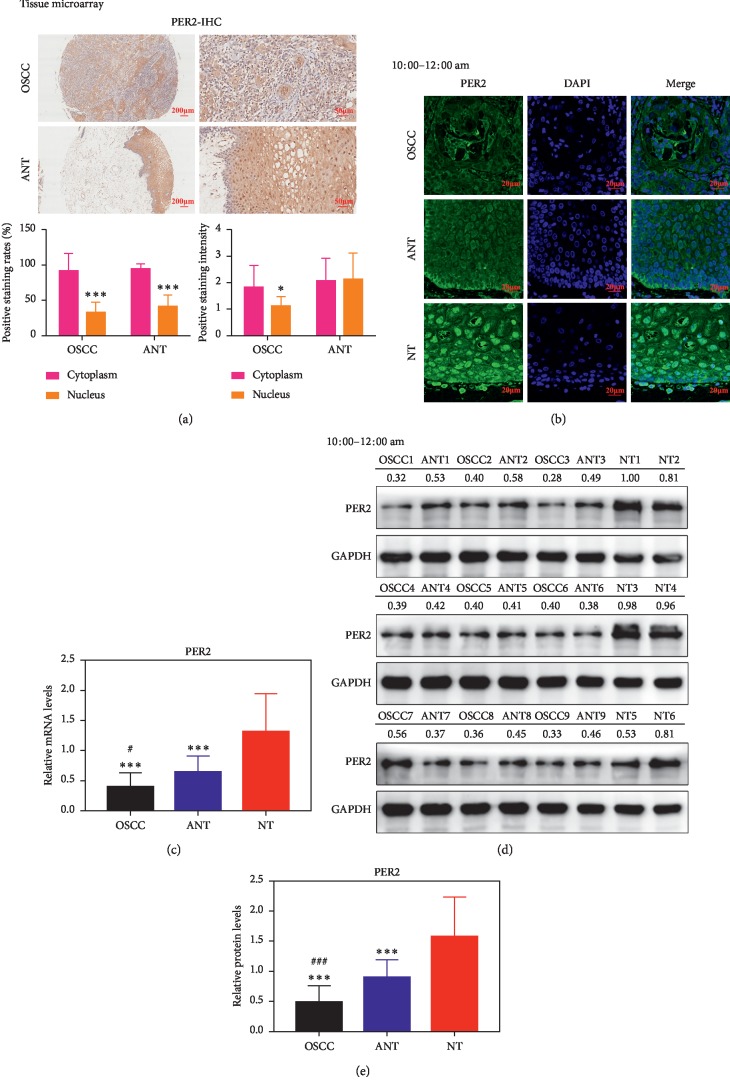
PER2 expression and nuclear translocation are disturbed in OSCC tissues and adjacent noncancerous tissues. (a) Detection of PER2 expression levels on a tissue microarray. (b) Immunofluorescence staining for PER2 (green) in the 36 paired collected tissue samples and the 36 normal samples. Nuclei were stained by DAPI (blue). (c) The relative mRNA levels of PER2 in the 36 paired collected tissue samples and the 36 normal samples. (d and e) Representative western blotting analysis of PER2 in the 36 paired collected tissue samples and the 36 normal samples. GAPDH was used as the loading control (OSCC, oral squamous cell carcinoma tissues; ANT, adjacent noncancerous tissues; NT, normal oral tissues). ∗∗∗P < 0.001 (compared with NT), #P < 0.05, and ###P < 0.001 (compared with ANT).